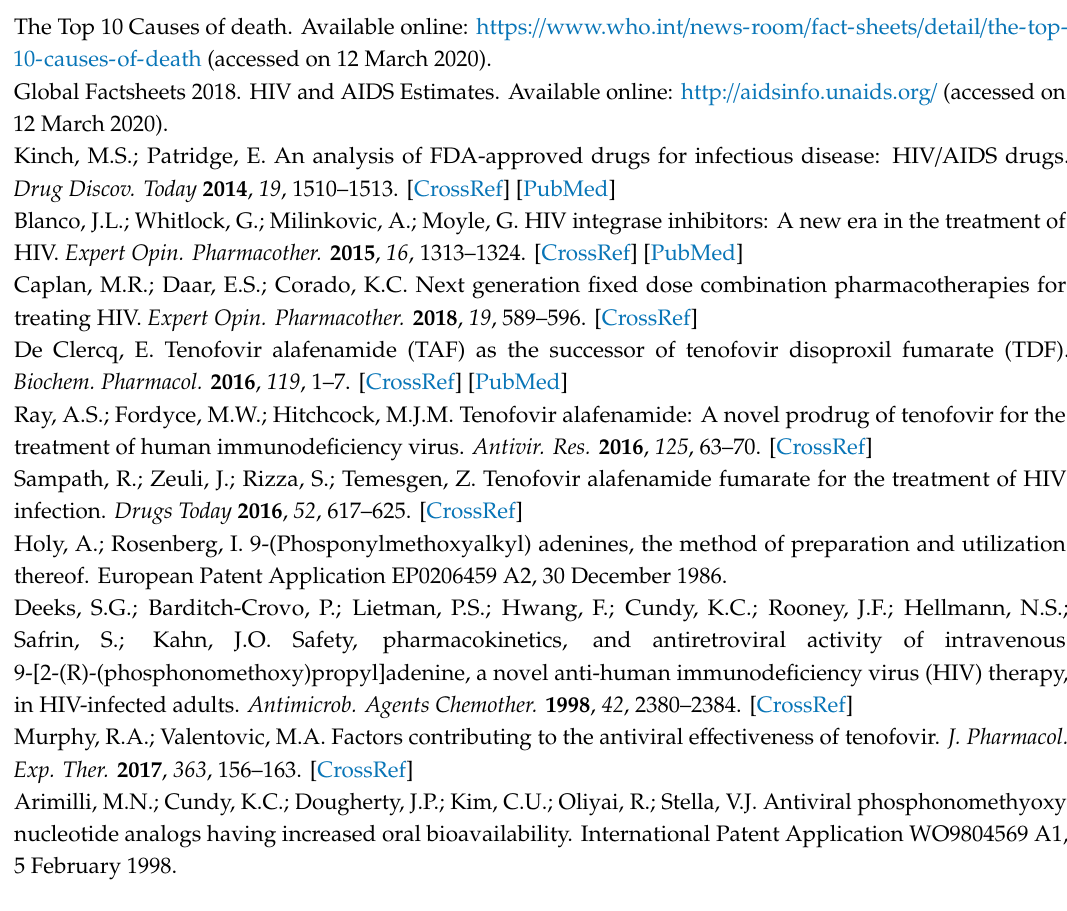
of TA, Figure S14: 1 H-NMR spectrum of TA HCl, Figure S15: 13 C-NMR spectrum of TA HCl, Figure S16: 1 H-NMR spectrum of TA HF, Figure S17: 13 C-NMR spectrum of TA HF, Figure S18: 1 H-NMR spectrum of TA MF1, Figure S19: 13 C-NMR spectrum of TA MF1, Figure S20: 1 H-NMR spectrum of TA MF2, Figure S21: 13 C-NMR spectrum of TA MF2, Figure S22: 1 H-NMR spectrum of TA MF3, Figure S23: 13 C-NMR spectrum of TA MF3, Figure S24: 1 H echo MAS NMR spectra of TA, TA HCl and TA HF, Figure S25: 1 H echo MAS NMR spectra of TA MF1, TA MF2 and TA MF3, Figure S26: 15 N CP MAS NMR spectra of TA MF1, TA MF2 and TA MF3, Figure S27: 15 N LG-CP MAS NMR spectra of TA MF1, TA MF2 and TA MF3, Table S1: detailed p -XRD data for TA HF, TA MF1, TA MF2 and TA MF3. CCDC 1990630 and 1990631 contain the supplementary